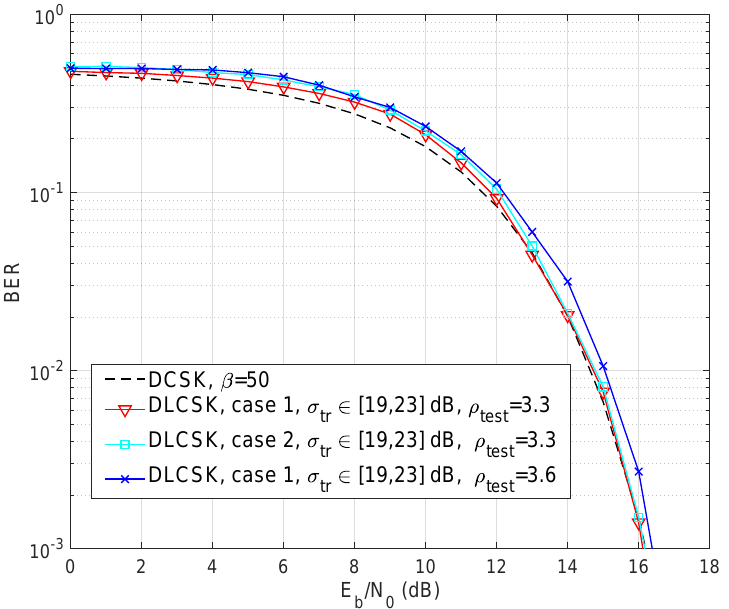
Figure 5. BER curve of the SISO DLCSK under AWGN channel, trained at a random SNR ∈ [ 19,23 ] dB, and β = 50, for case 1, and case 2. There is also the results for ρ test ∈ { 3.3,3.6 }